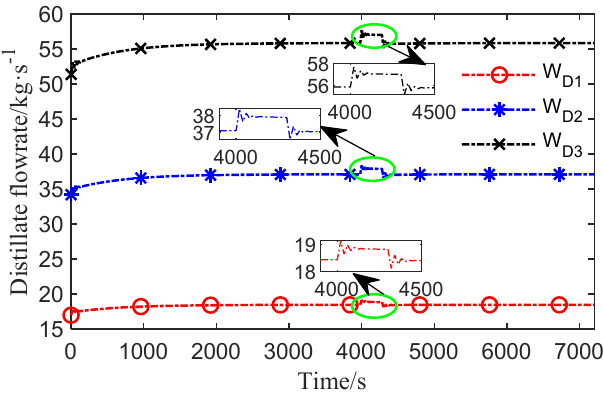
W . Figure 26. Dynamic of W D 1 , W D 2 , W D 3 for step increase in W Re